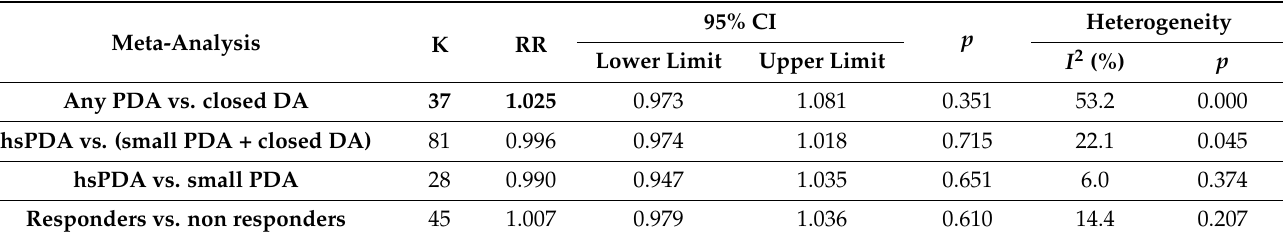
Table 1. Main meta-analyses.